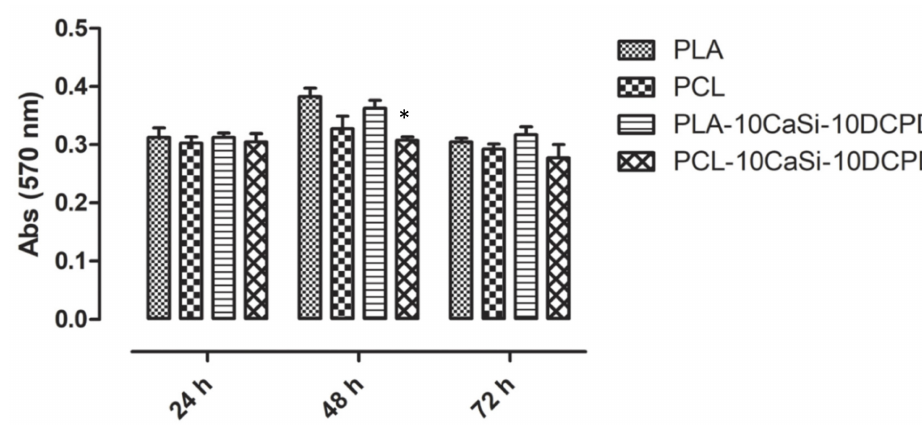
Figure 4. Metabolic activity of VW-MSCs seeded on the di ff erent sca ff olds after 24, 48 and 72 h of culture was evaluated by MTT based assay. The data represented as the mean ± SD of three independent biological replicates (n = 3), were analysed using one-way ANOVA followed by the Tukey’s post hoc comparison. Significant di ff erences among the experimental sca ff olds are represented by asterisks ( * ) ( p <